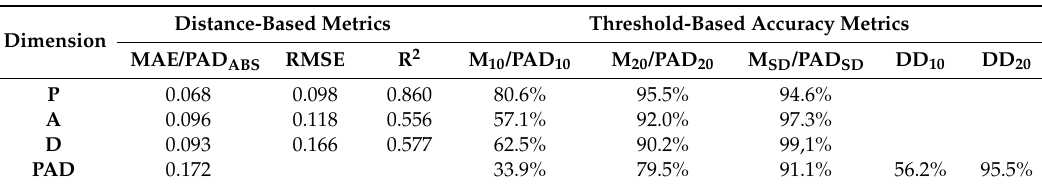
Table 5. Mapping accuracy metrics for the ANEW-MEHR